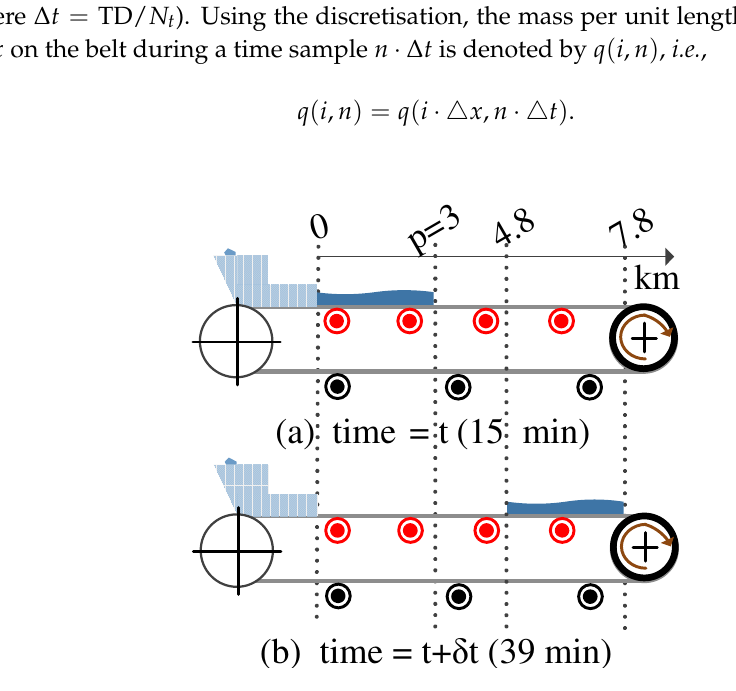
Figure 2. Wave-like property of material flow on the belt conveyor (BC). ( a ) time = t (15 min); ( b ) time = t + δ t (39